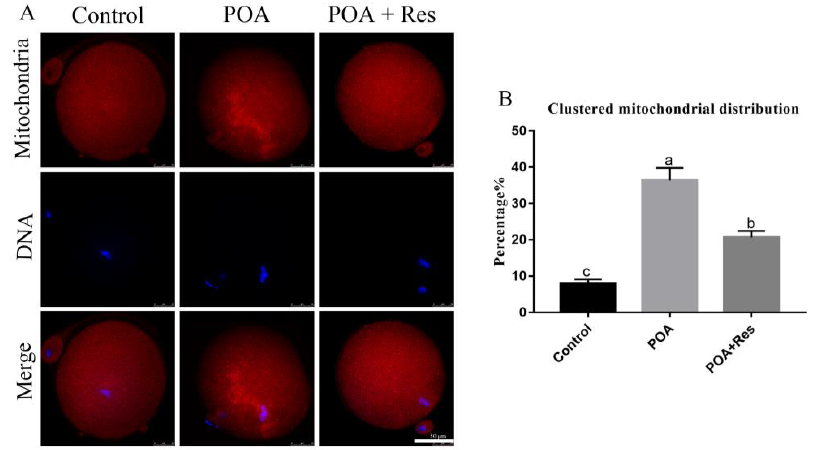
Figure 5. Resveratrol reduces the clustered mitochondrion distribution in POA oocytes. ( A ) Representative images of the mitochondrion distribution in the control, POA and resveratrol-treated POA (POA + Res) oocytes. Clustered distribution is in the POA and homologous distribution is in the control and POA + Res groups. Scale bar = 50 µ m. ( B ) The rates of clustered mitochondrial distribution in the control, POA and POA + Res groups. Data are presented as mean ± SEM from at least three independent experiments. a – c means not sharing a common superscript is different ( P < 0.05).